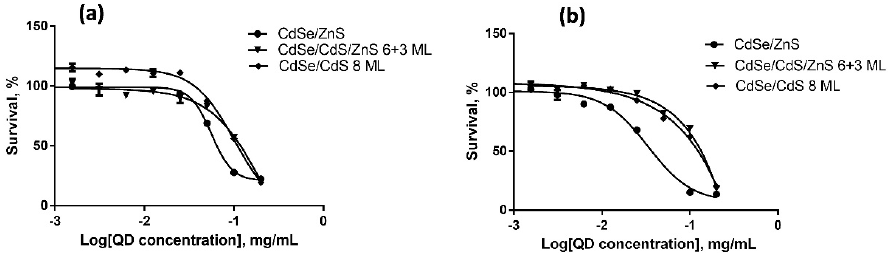
Figure 3. Survival of SK-BR-3 cells upon interaction with CdSe/ZnS-PEG-OH, CdSe/CdS/ZnS (6+3 ML)-PEG-OH, and CdSe/CdS (8 ML)-PEG-OH QDs for ( a ) 24 and ( b ) 48 h as dependent on the QD concentration.